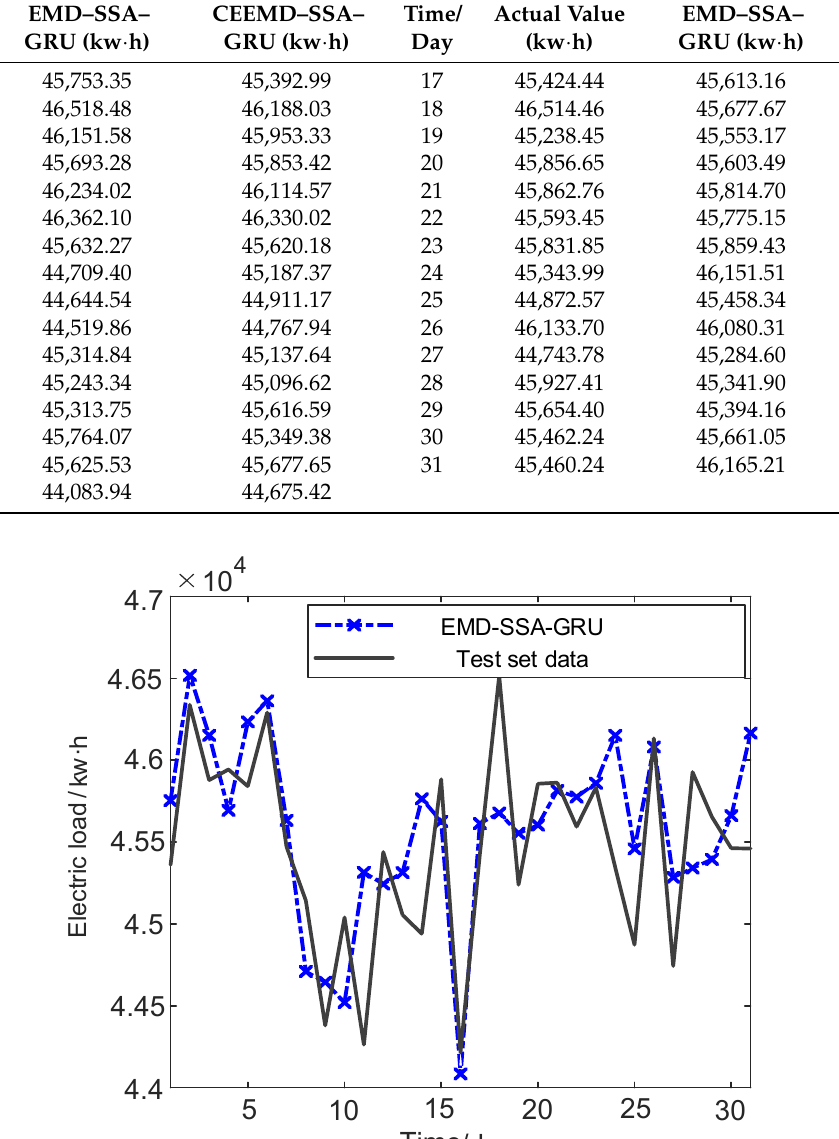
Table 4. Comparison of prediction results of two models.